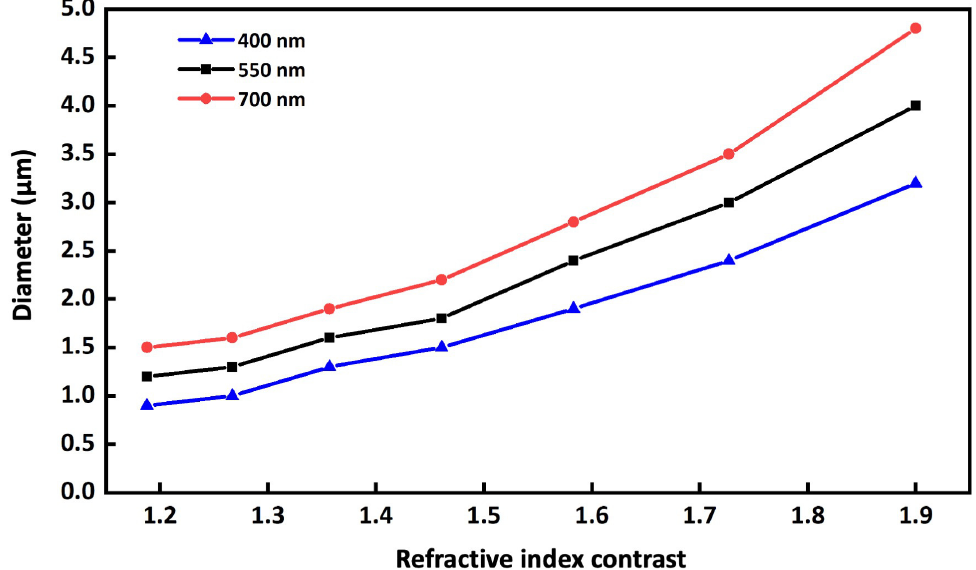
Figure 4. Critical diameters obtained at different illumination wavelengths as a function of the refractive index contrast between the microcylinder and